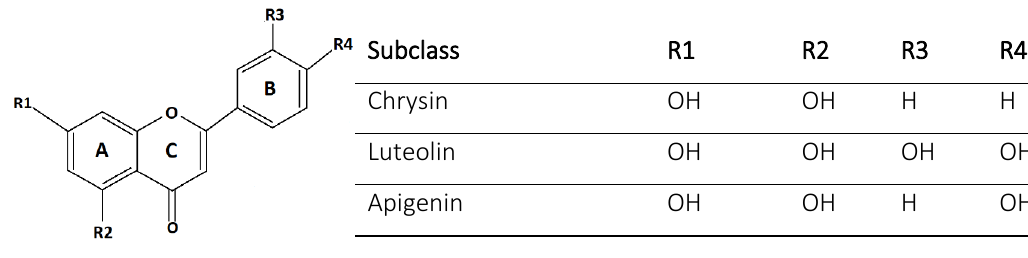
Figure 3. Flavones: chemical structure, types and substitution positions in the basic skeleton.